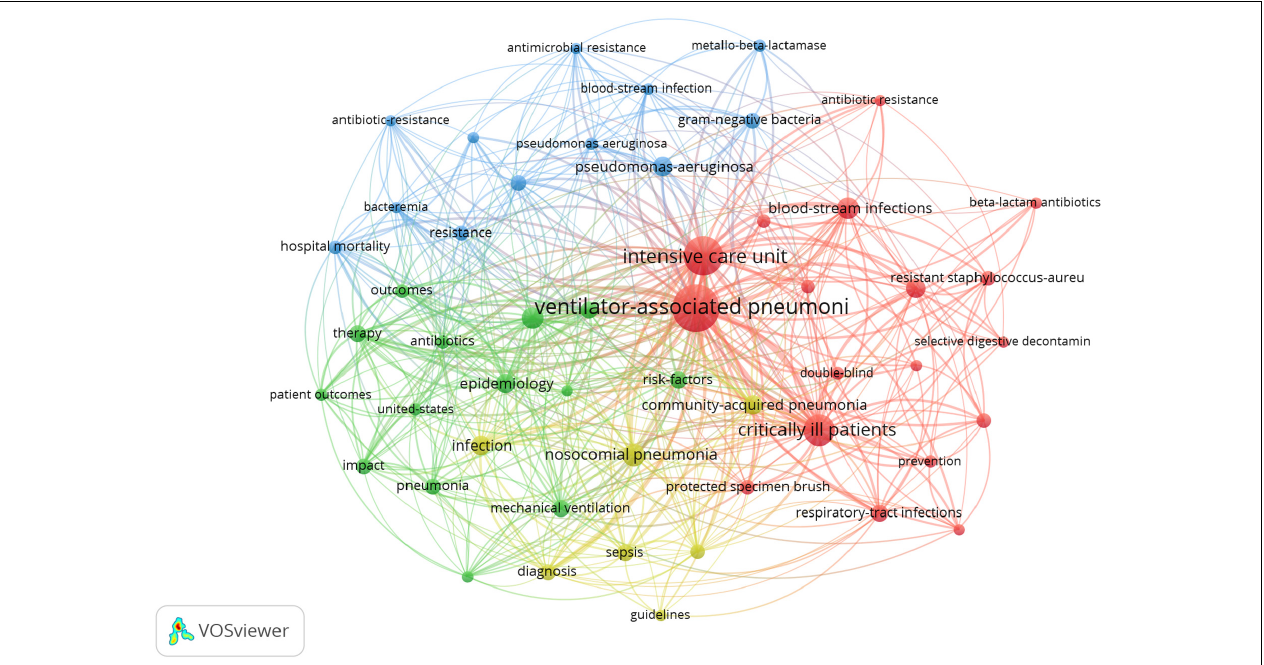
FIGURE 2 | Network visualization using words from the titles and abstracts of the 100 most-cited articles.